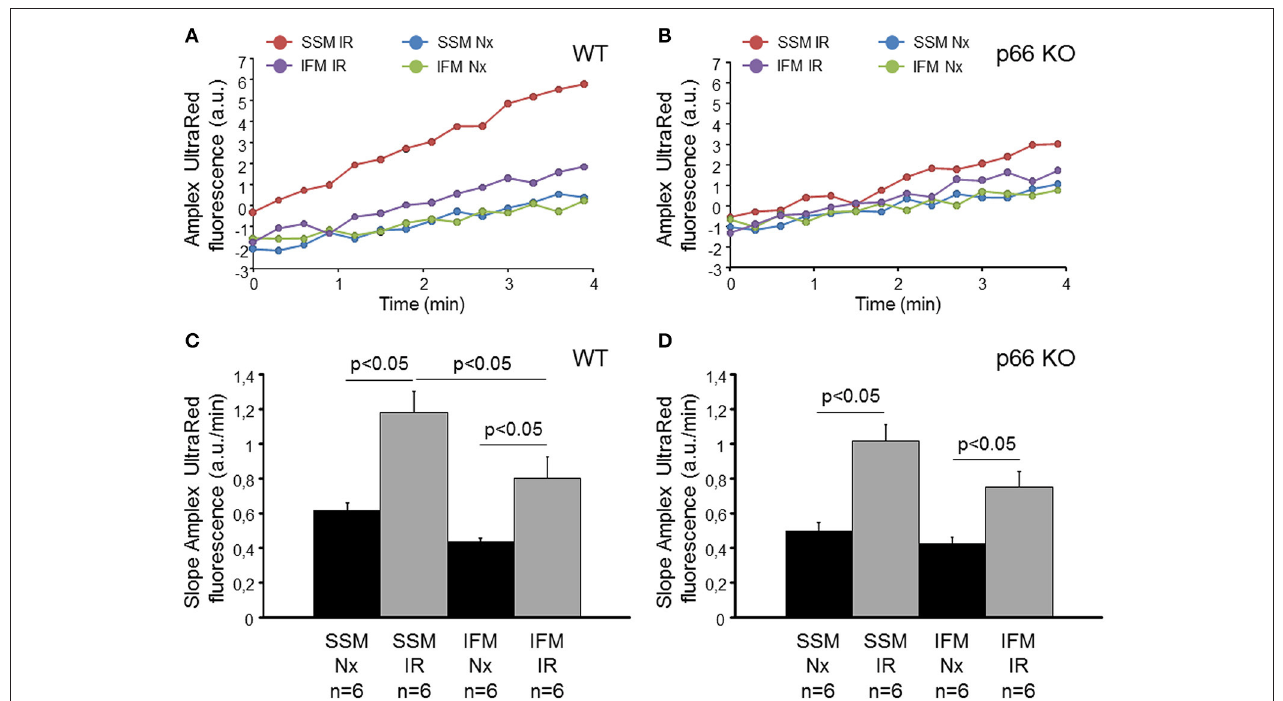
FIGURE 2 | ROS formation in SSM and IFM isolated from mouse hearts following normoxia or ischemia/reperfusion in vitro . Original traces showing Amplex UltraRed fluorescence in SSM and IFM isolated after normoxia (Nx) or ischemia/reperfusion (IR) in wildtype (WT, A ) or p66shc knockout (p66 KO, B ) hearts in vitro . Bar graphs represent the slope of the Amplex UltraRed fluorescence measured for 4 min in WT (C) and p66 KO (D) mitochondria.